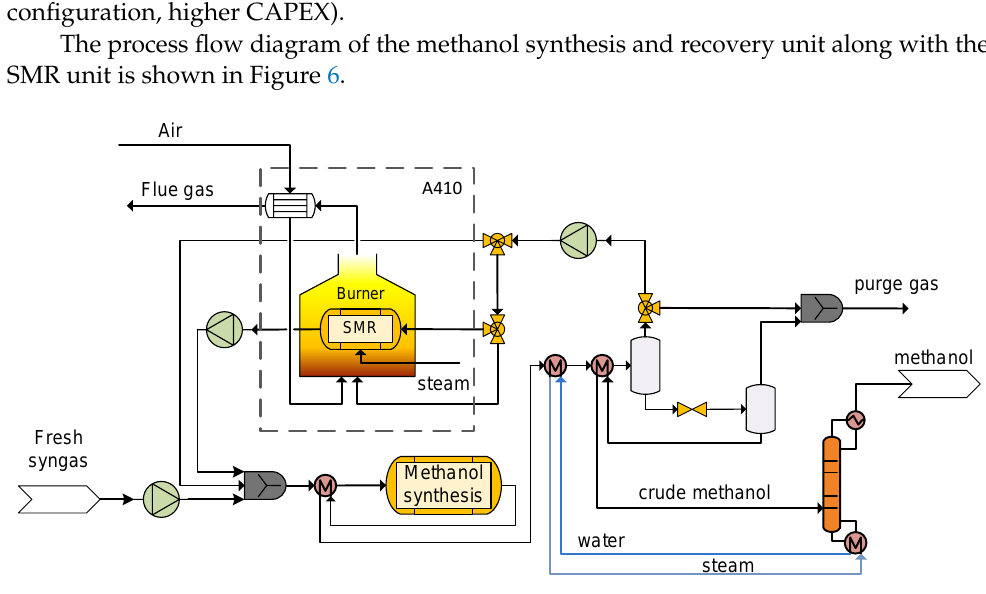
Figure 6 . Methanol synthesis and purification unit . Figure 6. Methanol synthesis and purification